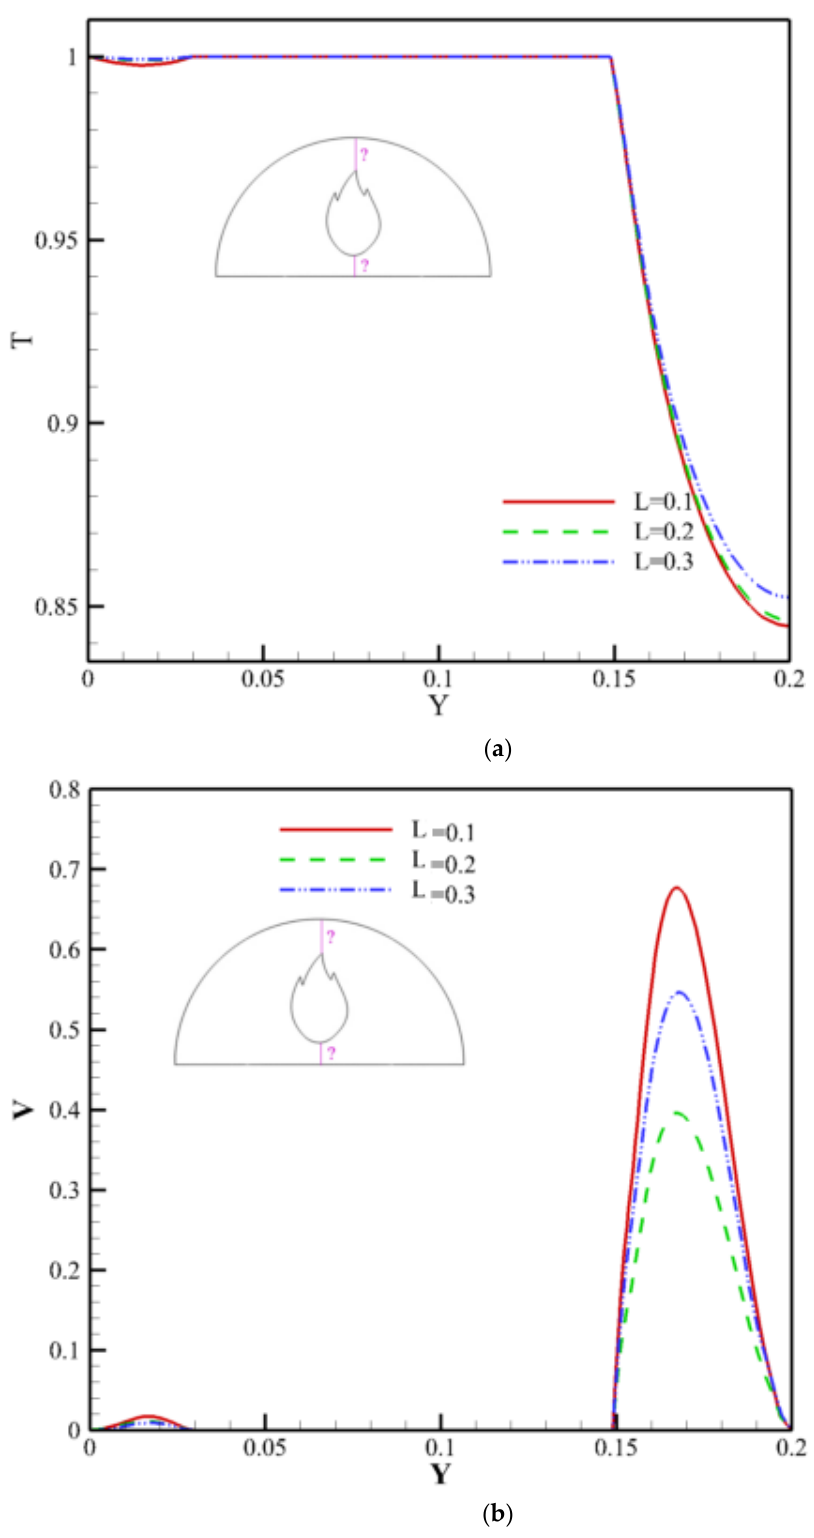
Figure 8. Variation of ( a ) temperature alongside mean vertical location ( b ) velocity alongside mean vertical location for different values for different values of heated length at ( φ = 0.02, Ha = 50, Rd = 0.5, Da = 10 − 4 and Ra = 10 5